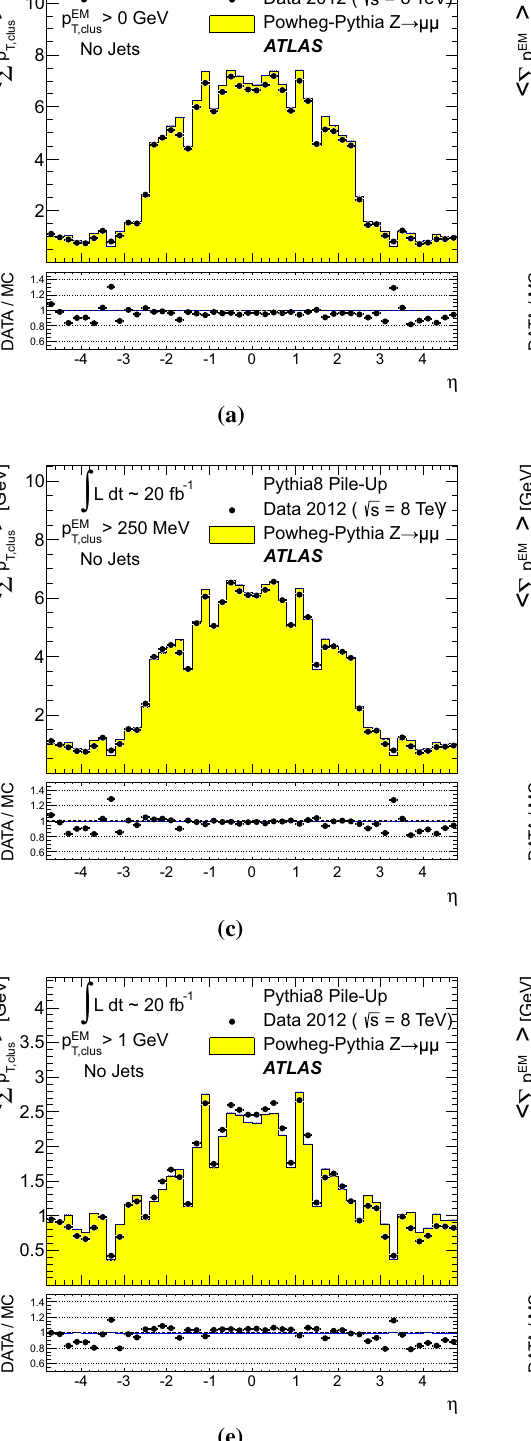
(cid:8) (η) from data and MC simulations T , clus